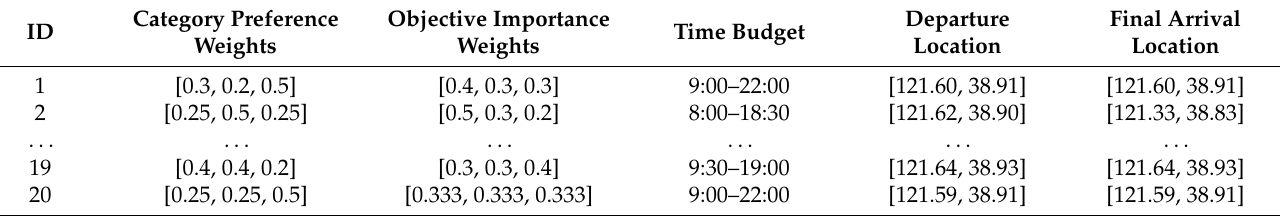
Table 4. Personalized information of the 20 designed tourist cases.